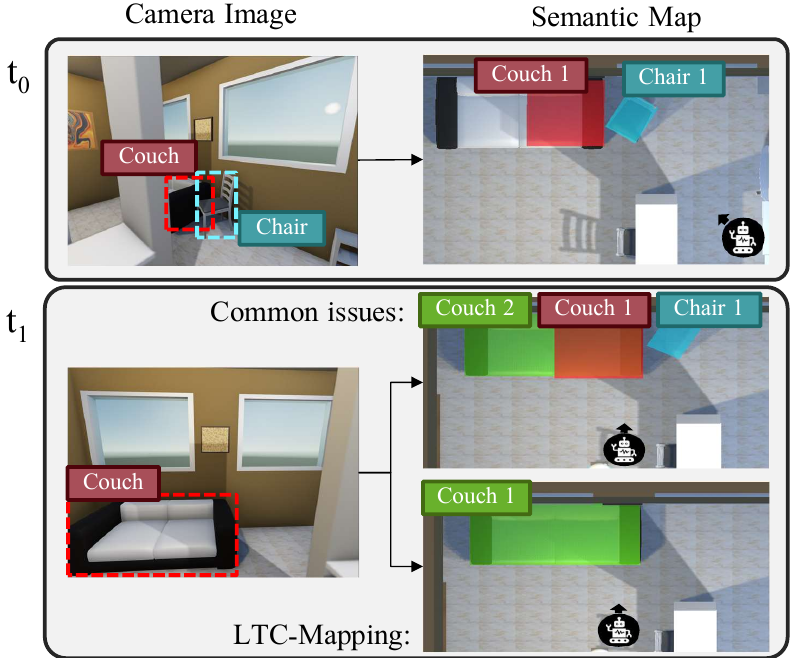
Figure 1. Illustration of the effects of two main challenges that compromise the reliability of semantic maps: instance duplication and dynamic objects. For each time moment t , we show the results yielded by the object detector ( left ) and the updated semantic map ( right ). At time t 0 , a chair and a partially visible couch are detected and instantiated in the map. However, at time t 1 , the previously detected chair has been moved and the couch is entirely visible. Ignoring the aforementioned challenges leads to the semantic map referred as Common issues, where two different instances refer to the same physical couch and the instance of the chair